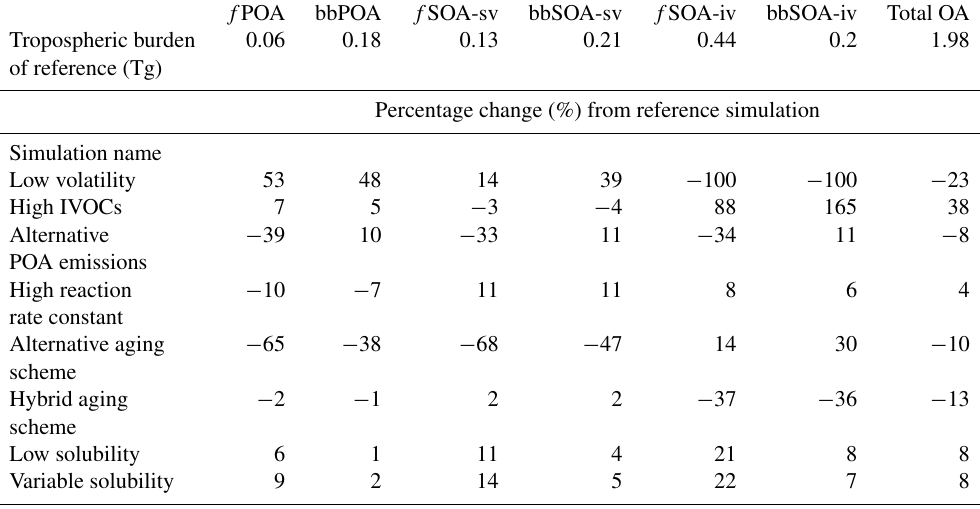
Table 4. Percentage change of the tropospheric burden of OA components for each sensitivity simulation relative to the reference simula- tion during the 2001–2010 decade. Positive change corresponds to an increase. The predicted tropospheric burden inTg of the reference simulation is also shown. f POA bbPOA f SOA-sv bbSOA-sv